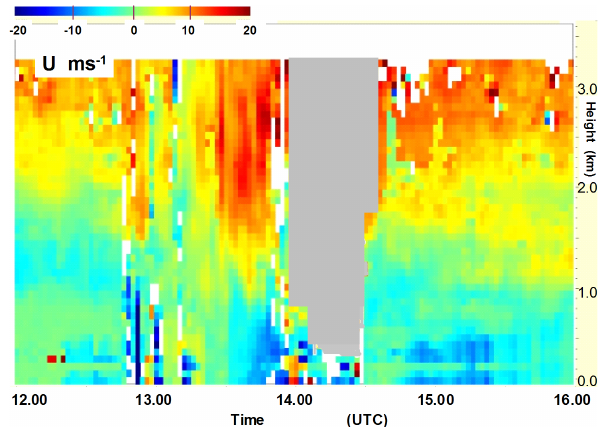
Fig. 8a. Wind U component measured by the wind profiler at Linkenholt 24 June 2005, 12:00 to 16:00UTC from 75 to 3250m a.g.l., doubtful measurements are greyed out.